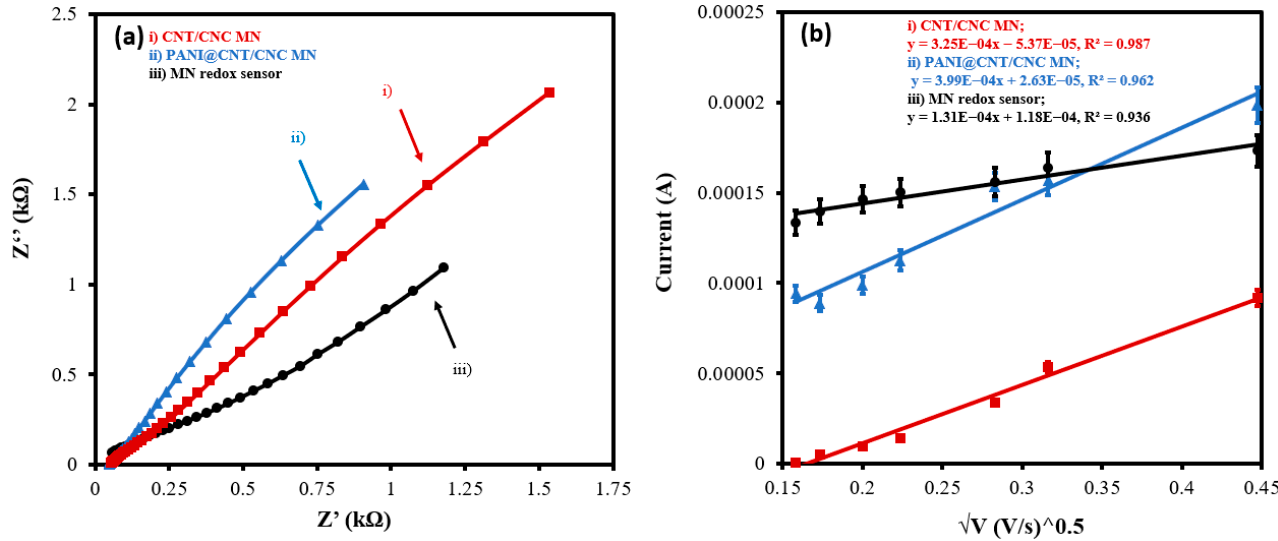
Figure 4. ( a ) Overlapped EIS Nyquist plots and ( b ) overlapped linear calibration plot of peak cathodic current vs. square root of scan rate for (i) CNT/CNC microneedle (MN); (ii) PANI@CNT/CNC MN; and (iii) MN redox sensor.